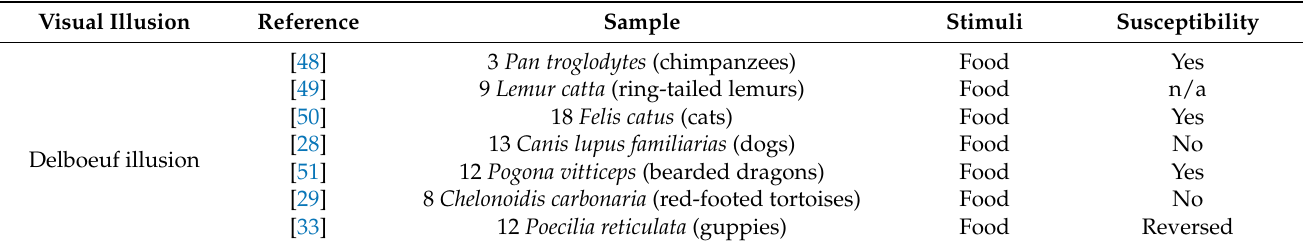
Table 1. Summary of the existing works on visual illusions adopting a spontaneous choice paradigm. Visual